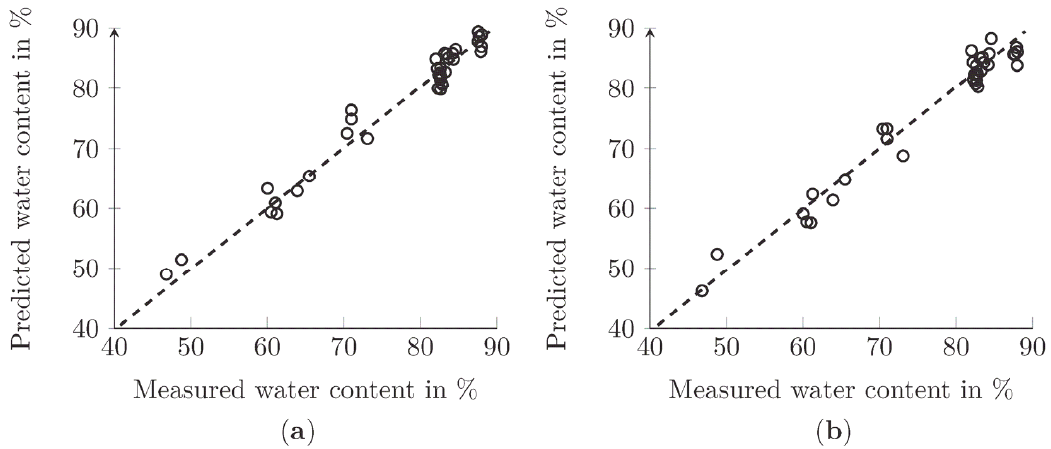
Figure 3. Measured versus predicted value of TWC for ( a ) absorbance and ( b ) reflectance data.